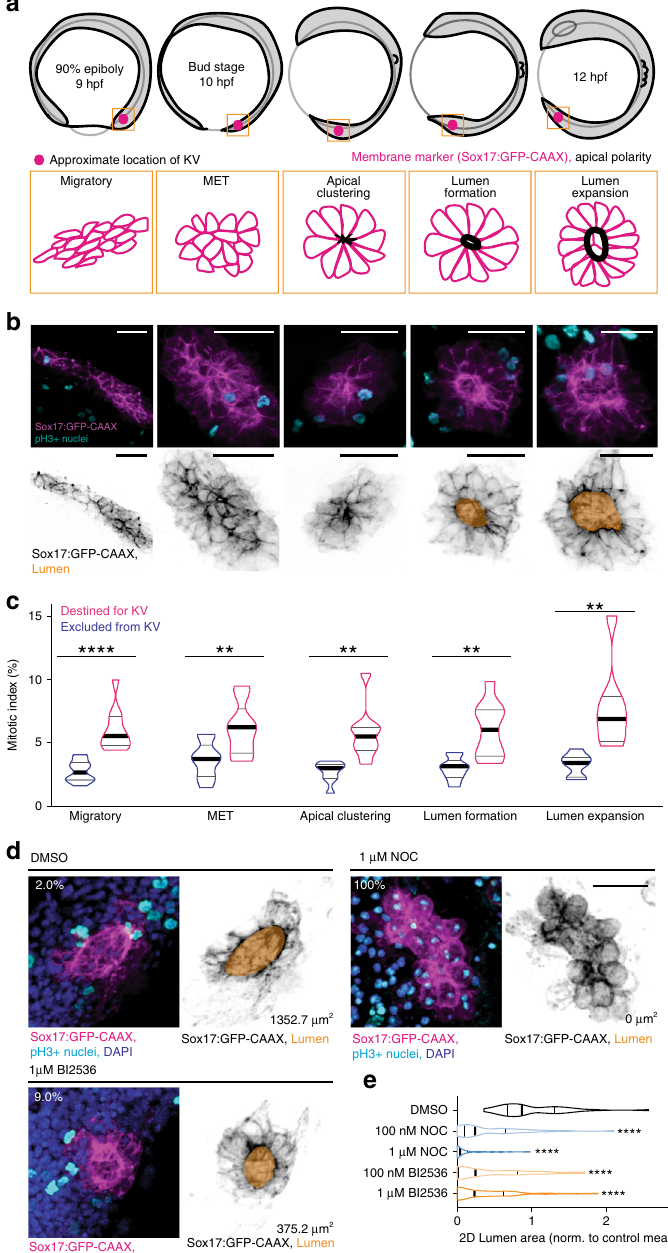
Fig. 1 Mitosis is required for lumen formation. a Model depicting zebra fi sh embryo (top) and KV morphology (bottom) during development. Approximate location of KV denoted by magenta spot. KV membrane (magenta) and regions of apical polarity (black) depicted in model below. b Top: maximum confocal projections of KV at developmental stages denoted in a . pH3 (mitotic nuclei, cyan) and KV membrane marker (Sox17:GFP-CAAX, magenta) shown. Bottom: KV membrane marker (Sox17:GFP-CAAX — gray) and lumen trace (orange) shown. Bars, 50 μ m. c Mitotic indices (%) represented as violin plot with endpoints depicting minimum and maximum values, quartiles depicted by thin black lines, median depicted by thick black line. n > 247 cells/stage, n = 43 embryos, two-tailed, unpaired Student ’ s t -test. Statistical results detailed in Supplementary Table 5. d Representative 3D renderings of KV under conditions of DMSO vehicle control, microtubule inhibition (1 μ M nocodazole), or PLK1 inhibition (1 μ M BI2536). Sox17:GFP-CAAX (magenta), pH3- positive nuclei (cyan), and DAPI (blue) shown on the left. Sox17:GFP-CAAX (gray) and lumen trace (orange) shown on the right. Percentages indicate mitotic index of image, lumen area denoted. Bar, 20 μ m. e Violin plot depicting normalized 2D lumen area under conditions represented in d with endpoints depicting minimum and maximum values, quartiles depicted by thin black lines, and median depicted by thick black line. One-way ANOVA with Dunnett ’ s multiple comparison and statistical results are detailed in Supplementary Table 5 (**** p < 0.0001 for n > 41